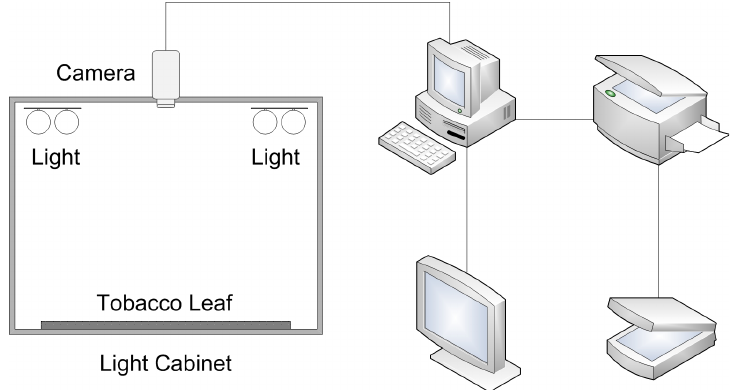
Figure 2. The image processing system of tobacco leaves